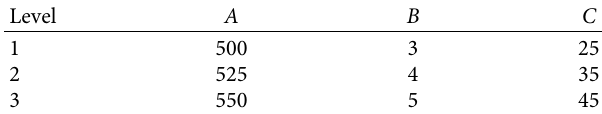
Table 1: The orthogonal experimental design’s factors and